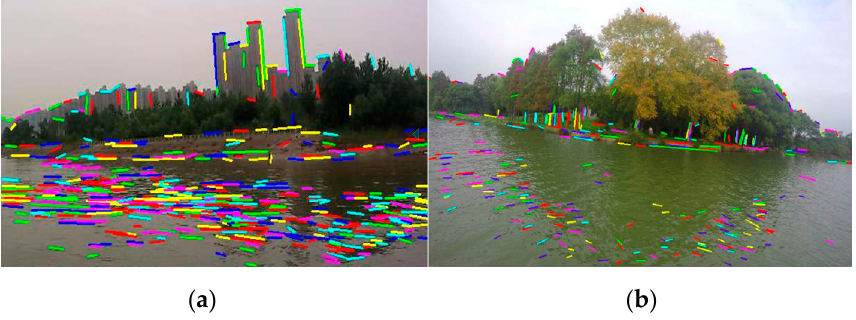
Figure 2. The results of line segment detection by the line segment detector (LSD) algorithm: ( a ) the line segments in the image include water ripple, trees, buildings, fences, shorelines, etc.; ( b ) the shoreline in the image is not straight.